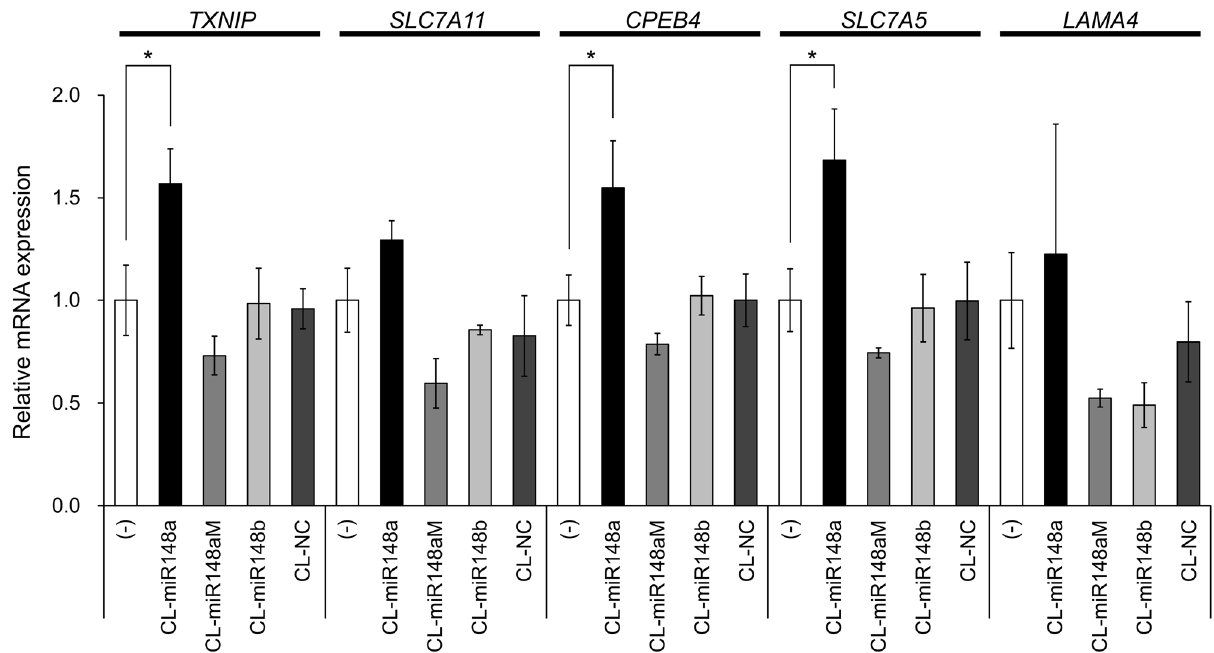
Figure 5. Changes in mRNA expression induced by CL-AMO transfection. The expression of the mRNA, relative to the control without AMO, was plotted against CL-AMOs. The name of each gene appears at the top of the graph, and the CL-AMO, including the control, is shown below the horizontal x-axis. Error bars represent SD; * p <